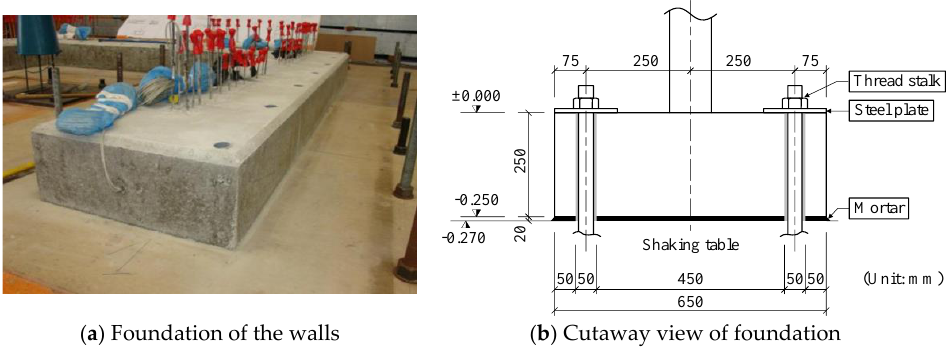
Figure 3. Wall foundation of the SMART 2013 RC structure [23]; ( a ) RC footing; ( b ) cutaway view.